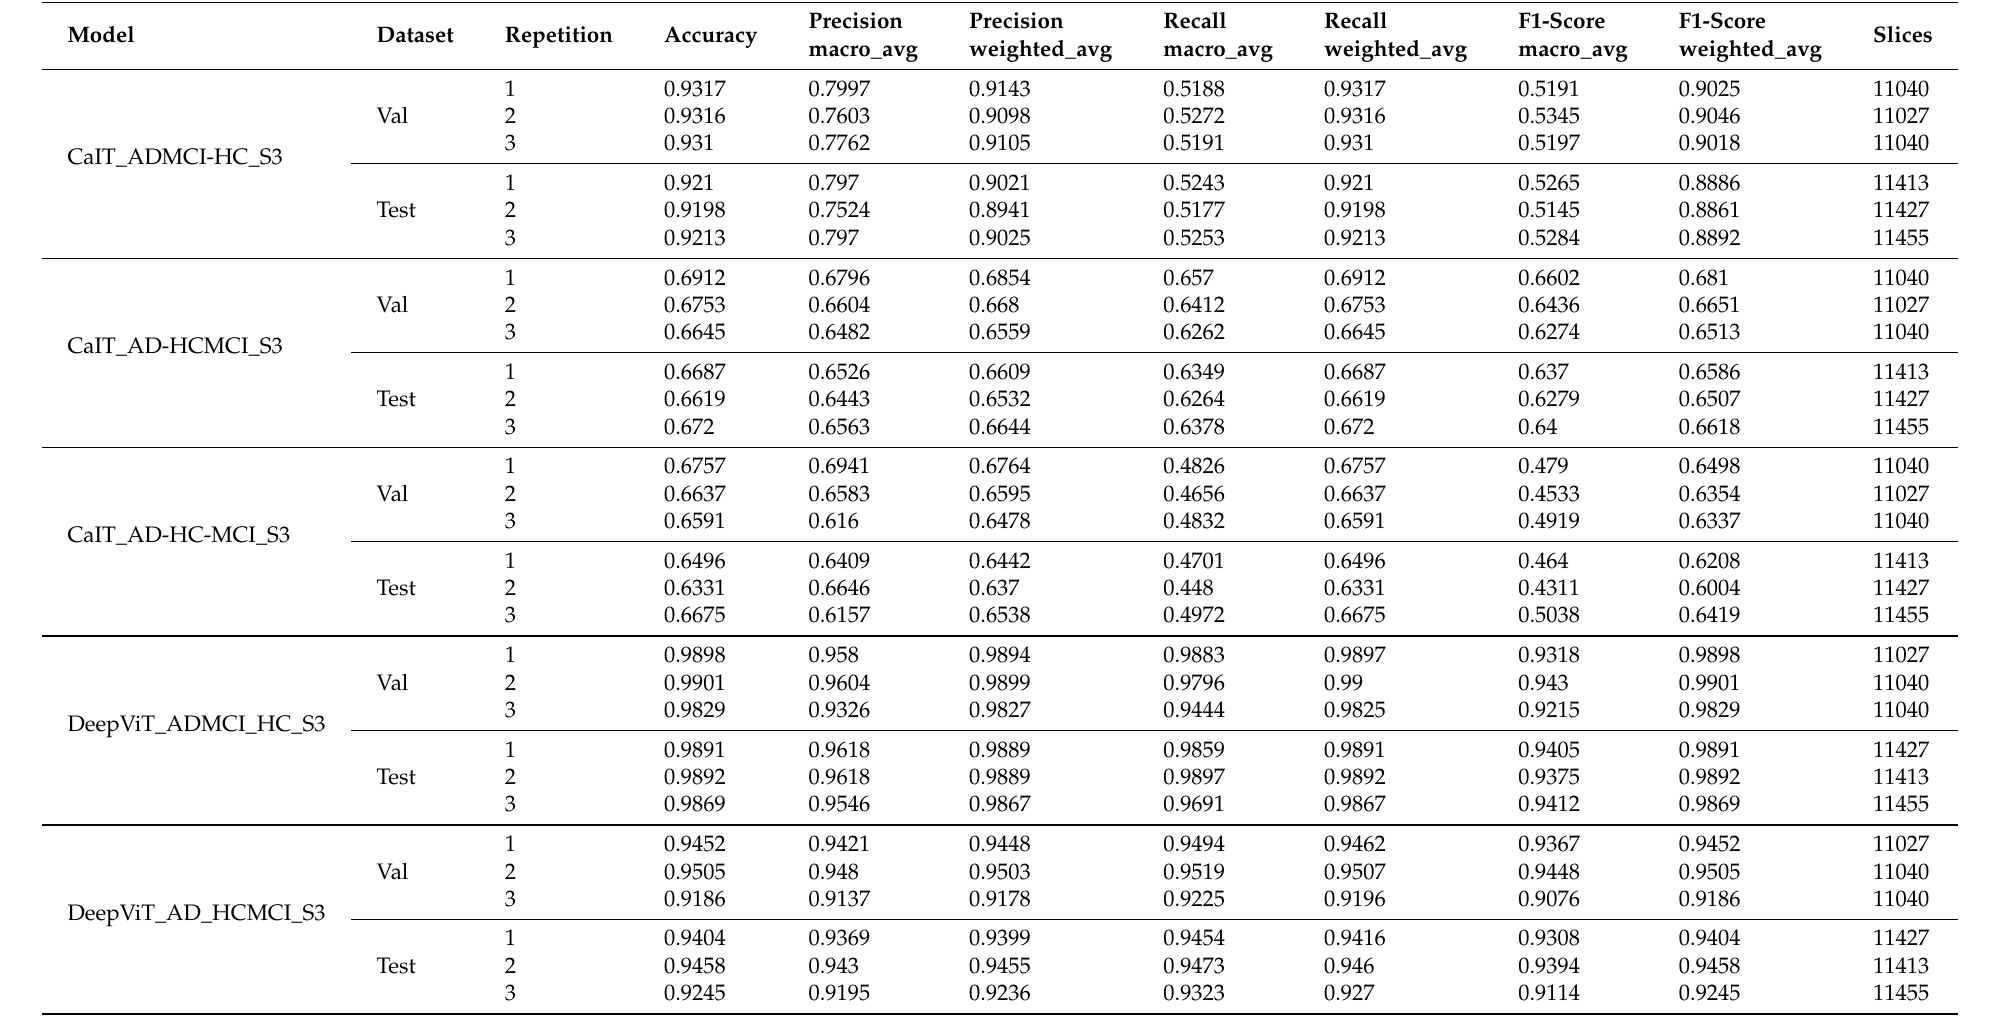
Table A3. The slice-level performance of structural MRI models using the preprocessed data with spatial smoothing sigma = 3 mm (S3). The naming convention for models and classes is as in the previous tables.